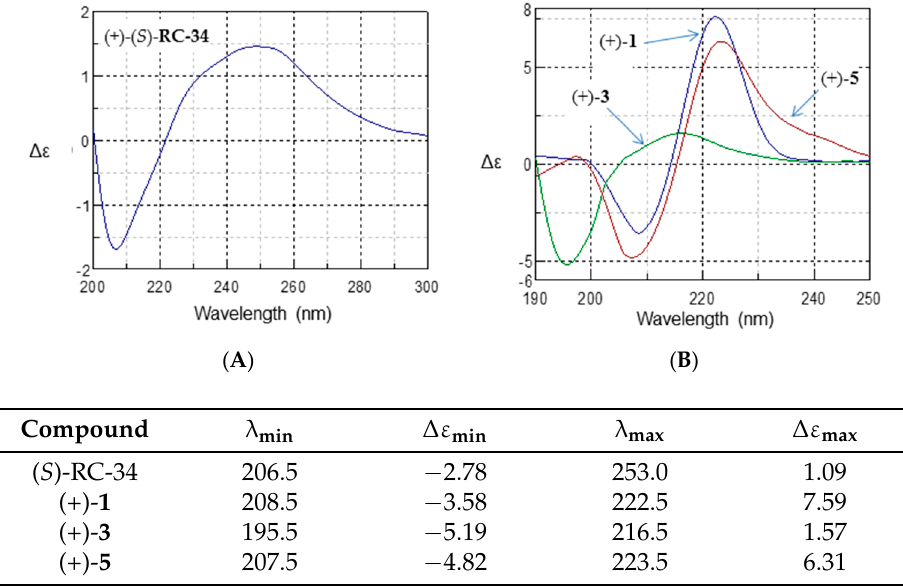
Figure 4. ECD curves of ( A ) (+)-( S )-RC-34 and ( B ) (+)- 1 , (+)- 3 , (+)- 5 and their Cotton effect (CE) in the wavelength range 190–300 nm.